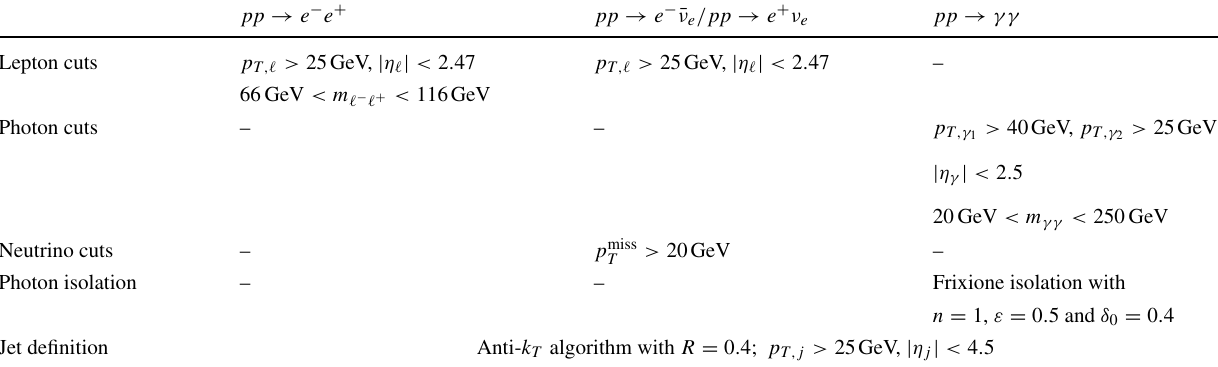
Table 8 Default setup of fiducial cuts for Z γ and W ± γ production processes